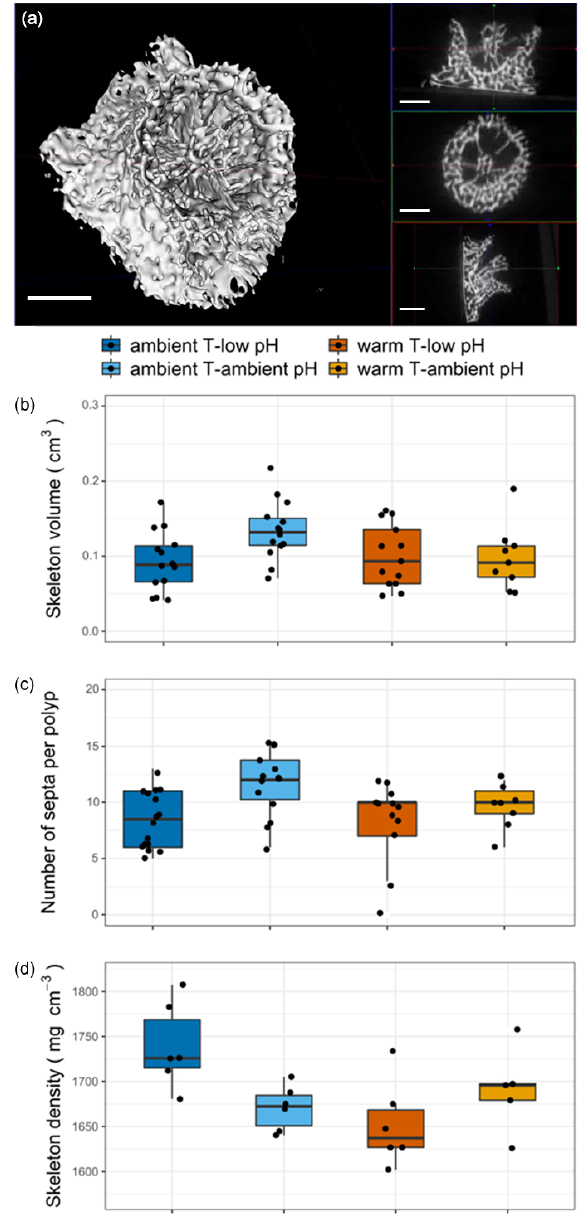
Figure 4. Nine-month recruit skeletons of A. calycularis under the two temperature treatments (23 ◦ C for ambient temperature and 26 ◦ C for warm temperature) and the two pH treatments (pH T = 8 . 05 ± 0 . 09 for ambient pH and pH T = 7 . 78 ± 0 . 10 for low pH). (a) 3D picture of a recruit skeleton by micro-CT scanning, scale: 1mm; see also Video S4. (b) Volume of the recruit. n = 9–16 per temperature and pH treatment. (c) Number of septa per skeleton. n = 9–16 per temperature and pH treatment. (d) Skeleton density. Values have been obtained by micro-CT scanning. n = 6 per tem- perature and pH treatment. Dots represent the number of septa per recruit coral skeleton, and the density of the recruit’s coral skeleton and boxes represents the median and 25% and 75% quartiles. The color of the boxes indicates the temperature and pH